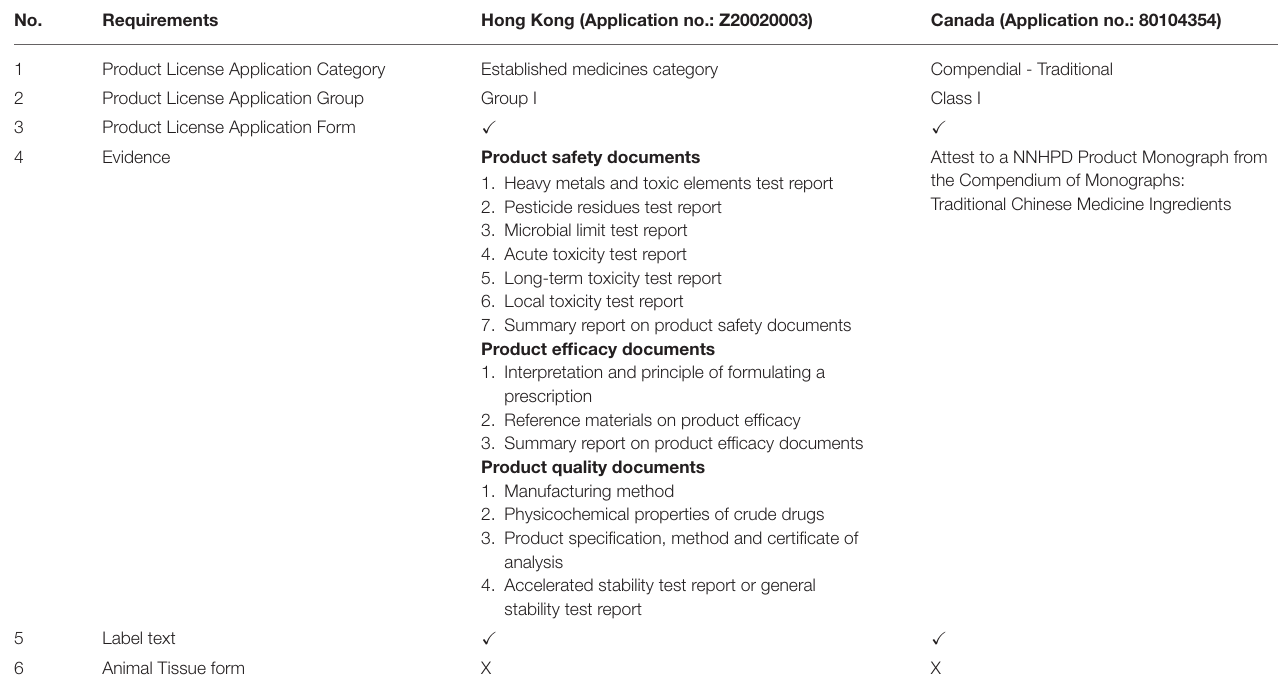
TABLE 5 | Zhizhu Kuanzhong Capsule - product license application in Hong Kong and Canada (8, 9).